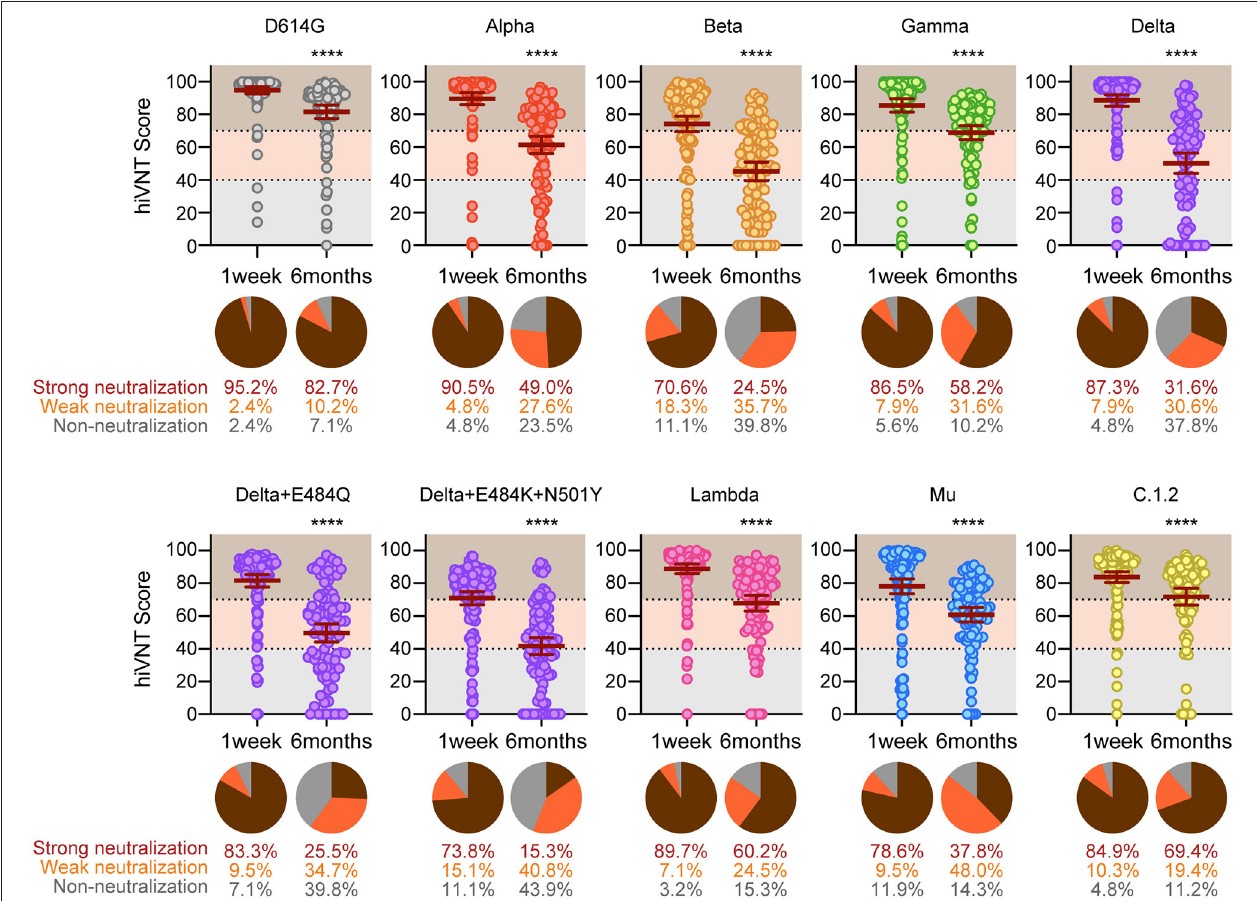
FIGURE 3 | Long-term analysis for vaccine-elicited antibodies against the indicated strains. Positive rates for neutralizing antibodies determined via a qualitative hiVNT ( n = 126 for 1 week and n = 98 for 6 months after the second dose) against the indicated variants. The mean of two independent determinations is plotted. The brown lines indicate the mean ± 95% confidence intervals. The percentage of neutralization potency based on the hiVNT score of each serum sample against the indicated variants is shown in the pie chart. An hiVNT score below 40 (equivalent to pvNT 50 < 50) indicates non-neutralizing serum, a score of 40–70 (equivalent to pvNT 50 > 50 but < 200) indicates weakly neutralizing serum, and a score above 70 (equivalent to pvNT 50 > 200) indicates strongly neutralizing serum. See also Supplementary Figure 1 for a description of this definition. The mean of two independent determinations is plotted. **** P < 0.0001 (unpaired t